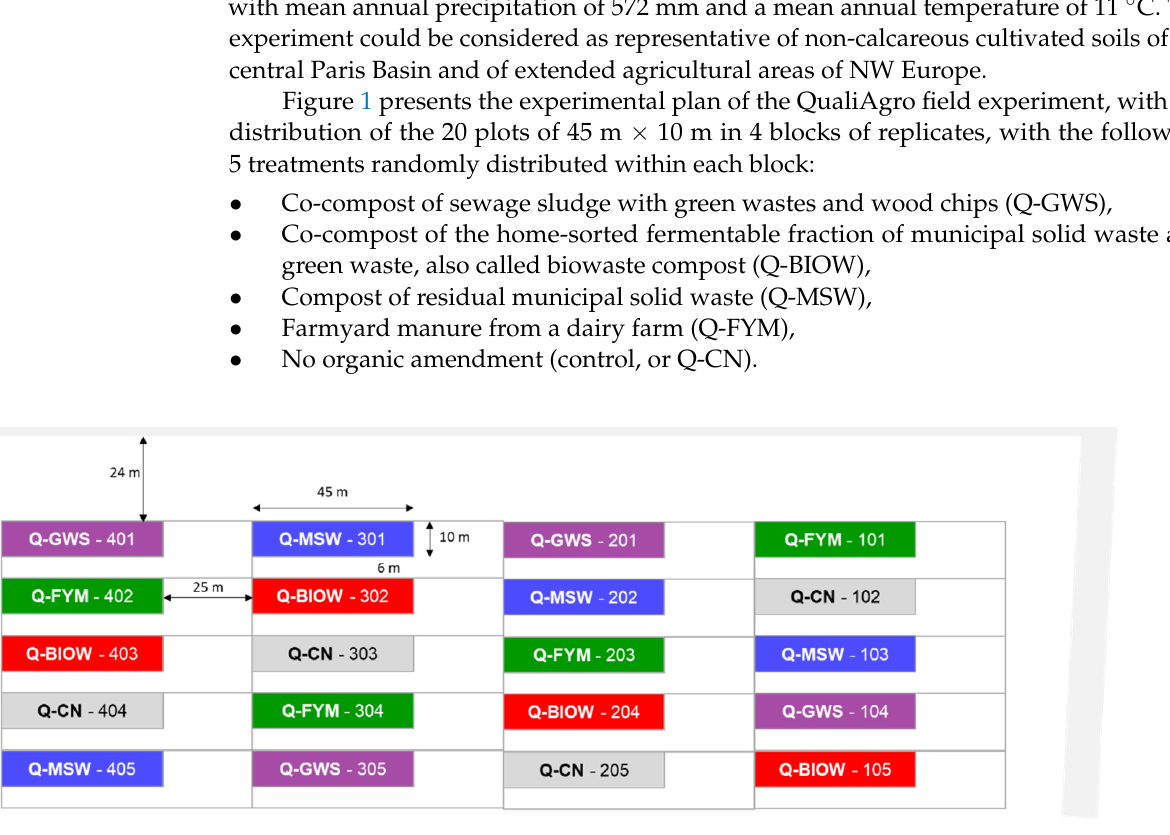
Figure 1. Experimental plan of the QualiAgro site, with the following organic waste product (OWP) treatments applied: co-compost of sewage sludge and green waste (Q-GWS), biowaste compost (Q-BIOW), compost of residual municipal solid waste (Q-MSW), farmyard manure (Q-FYM) and no organic amendment (Q-CN).